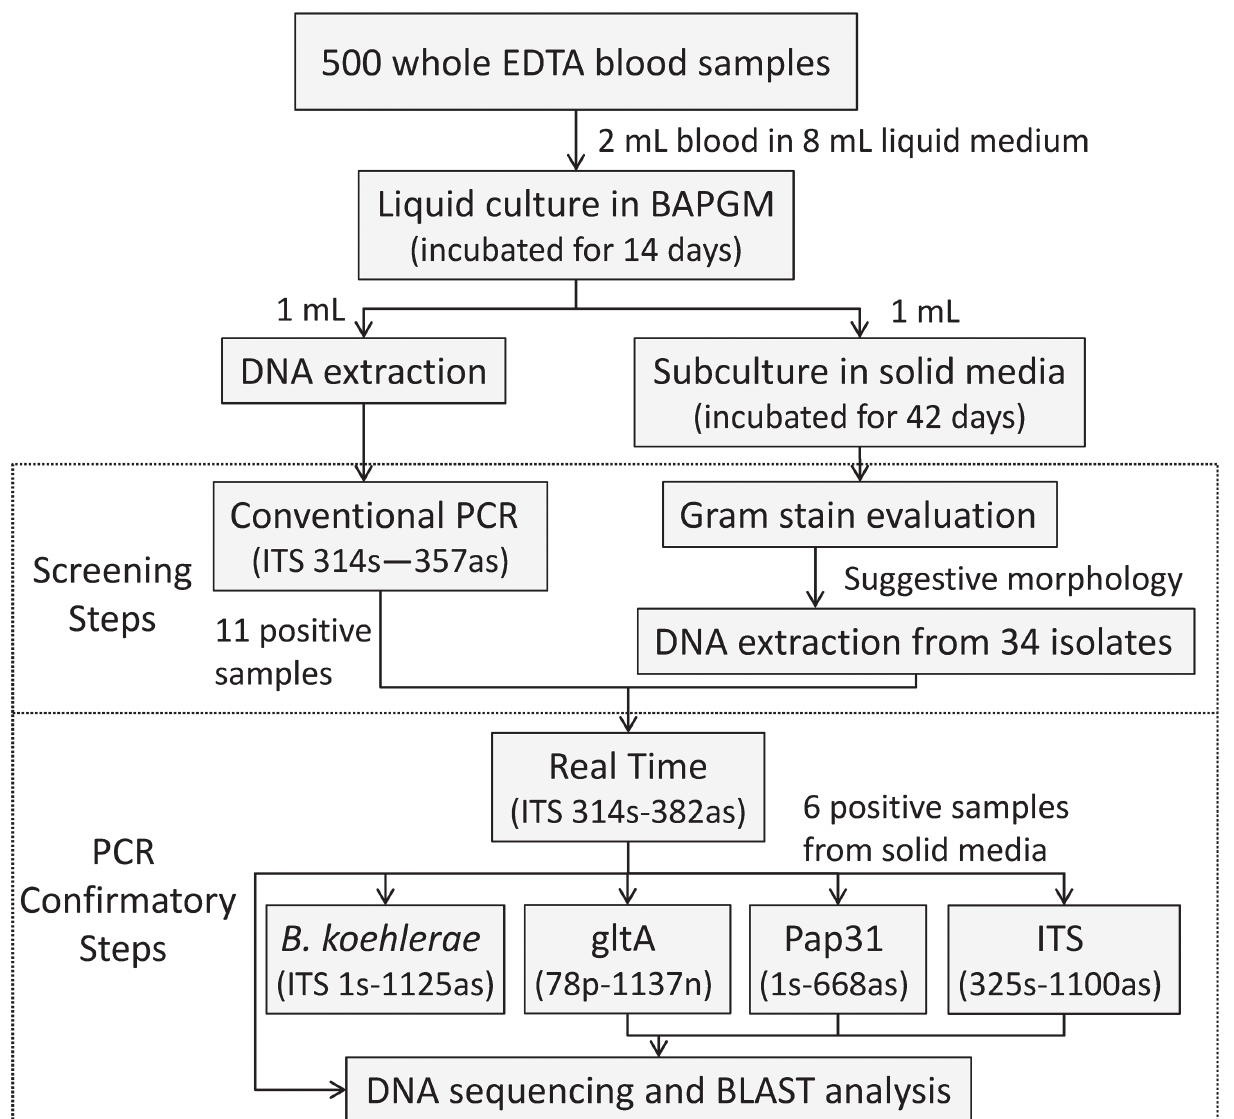
Figure 1. Flowchart of the culture and PCR-based procedures performed to determine Bartonella prevalence in 500 blood donors from Campinas, Brazil.